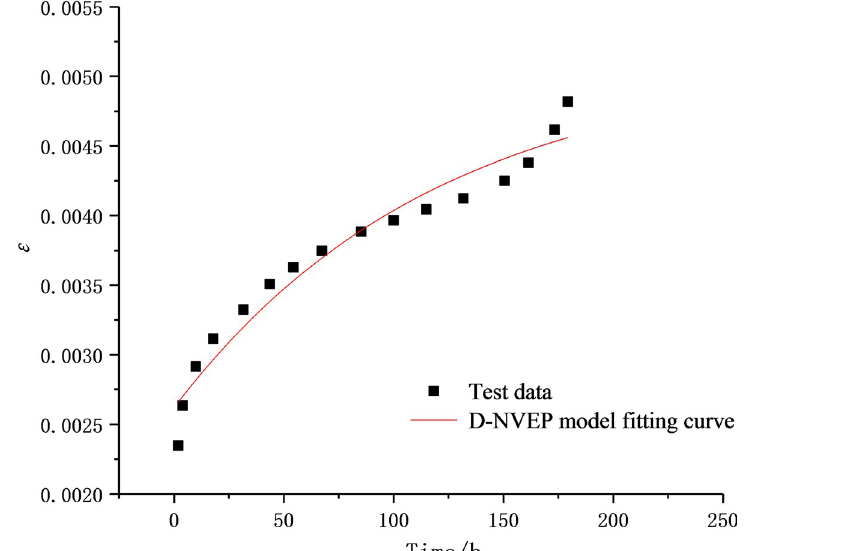
Fig 13. Fitting curve of D-NVEP model (without initial value).